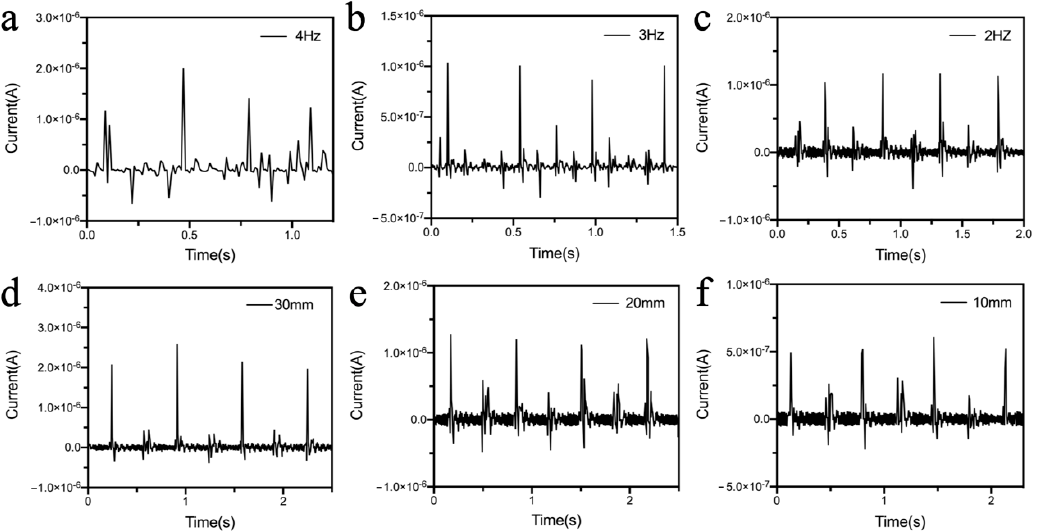
Figure 4. Output current signals at different vibration statue. ( a ) The vibration frequency is 4 Hz and the vibration amplitude is 20 mm. ( b ) The vibration frequency is 3 Hz and the vibration amplitude is 20 mm. ( c ) The vibration frequency is 2 Hz and the vibration amplitude is 20 mm. ( d ) The vibration frequency is 2 Hz and the vibration amplitude is 30 mm. ( e ) The vibration frequency is 2 Hz and the vibration amplitude is 20 mm. ( f ) The vibration frequency is 2 Hz and the vibration amplitude is 10